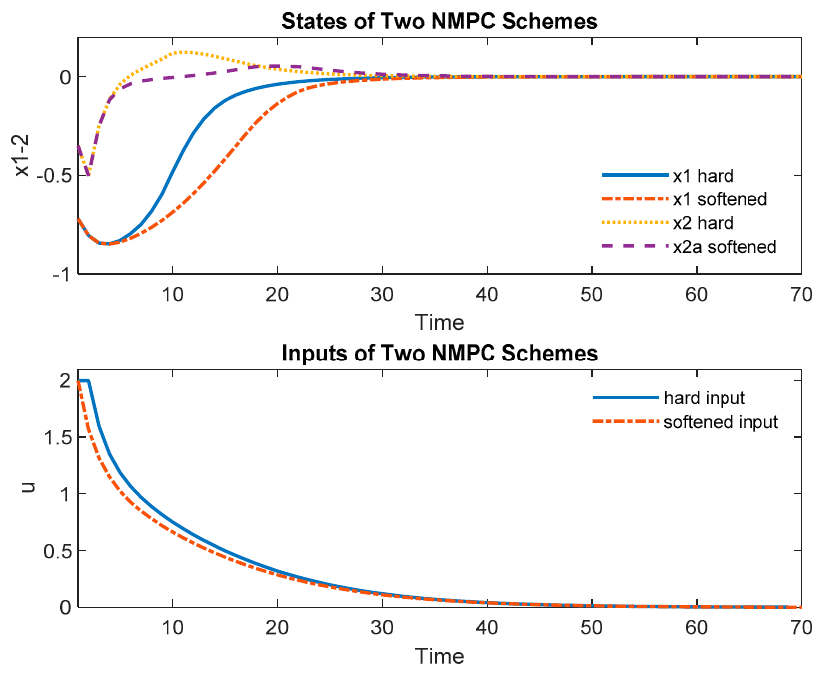
Figure 4. Performance of the two NMPC schemes.